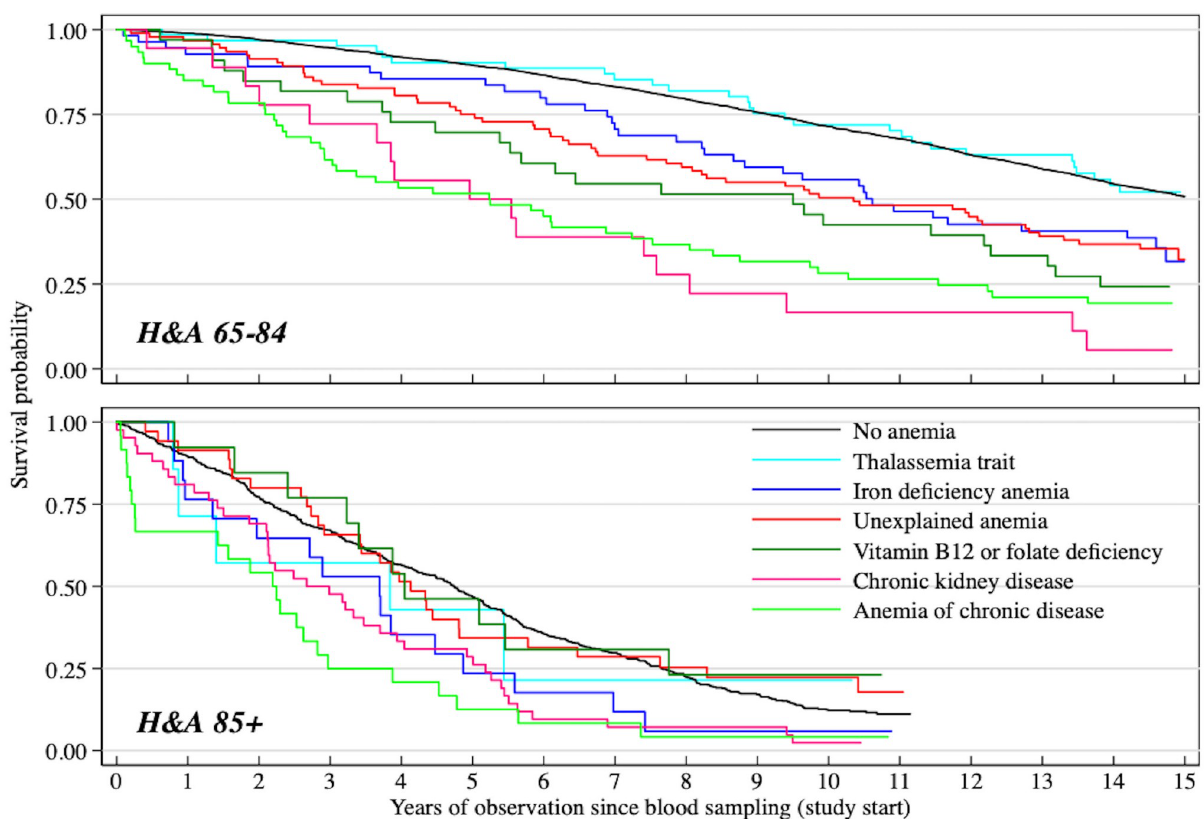
Fig 3. Survival by mild anemia type in the Health and Anemia (H&A) population-based study. Kaplan-Meier curves for individuals aged 65–84 years (H&A65-84) and 85 years or older (H&A85+) . Mild anemia was defined as hemoglobin concentration between 10.0 and 11.9 g/dl in women and between 10.0 and 12.9 g/dl in men [20,